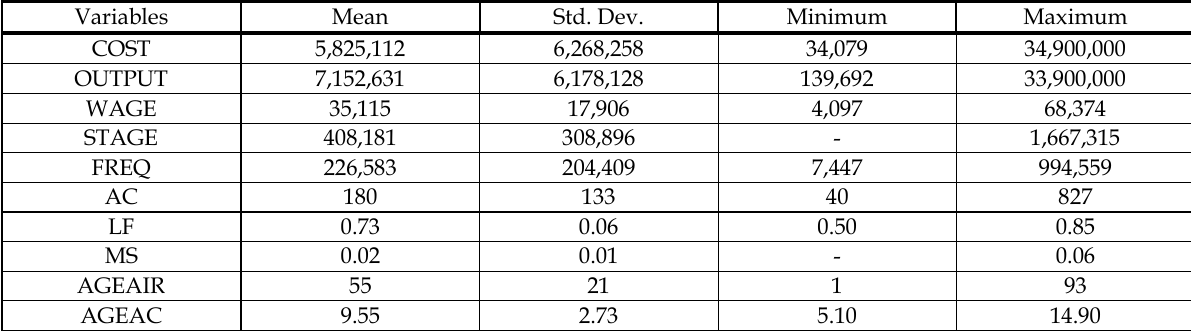
Summary Statistics of Airlines’ Cost Data (582